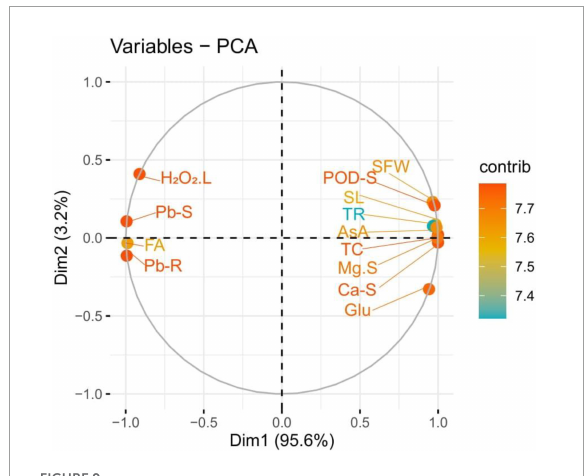
FIGURE9 Loading plots of principal component analysis (PCA) of various growth attributes of Solanum lycopersicum with Pb uptake under various application levels of syringic acid grown in Pb-contaminated soil. Different abbreviations used in the figure are as follows: Pb-S, lead concentration in the shoots; FA, fumaric acid; Pb-R, lead concentration in the roots; Glu, glucose content; SL, shoot length; AsA, ascorbic acid content; SFW, shoot fresh weight; POD-S, peroxidase activity in the shoots; TR, transpiration rate; Mg-S, magnesium content in the shoots; TC, total chlorophyll content; and Ca-S, calcium content in the